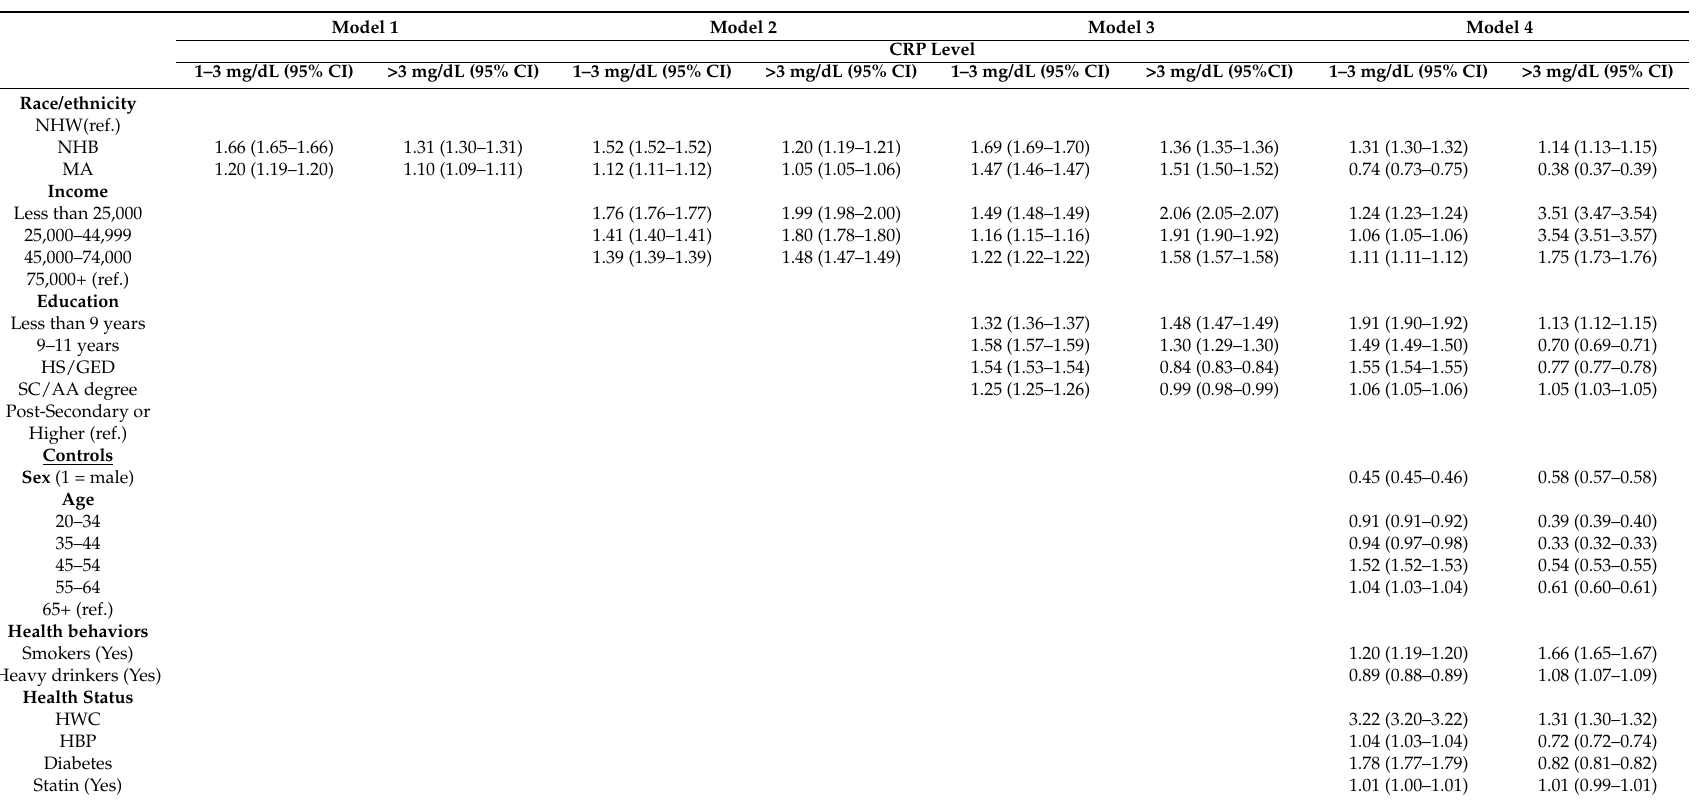
Table 3. Multinomial regression models for intermediate and high levels of C-reactive protein by race/ethnicity, national health and nutrition examination survey, United States,